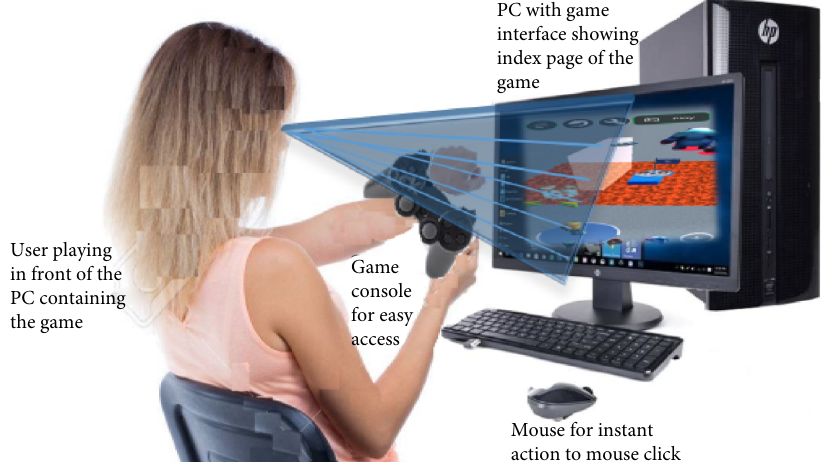
Fig. 2 An experimental setup that involves a participant sitting in front of a PC with game interface and a console controlling the game on index page: The mouse and keyboard can be used to direct any quick access to score a higher